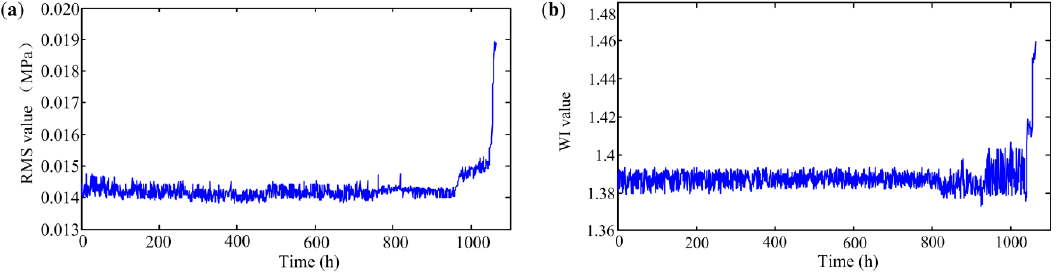
Figure 10. The obtained DI based on different time-domain statistical indicators; ( a ) RMS ( b ) WI.